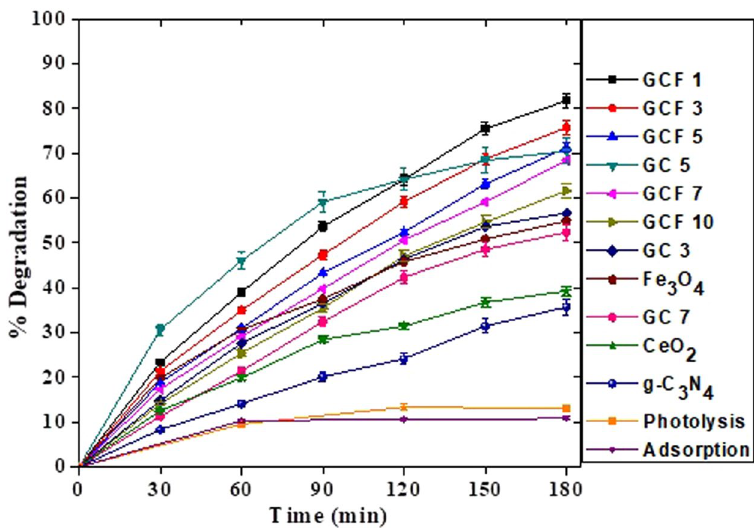
Figure 9. Photocatalytic 2-CP degradation using pristine and modified